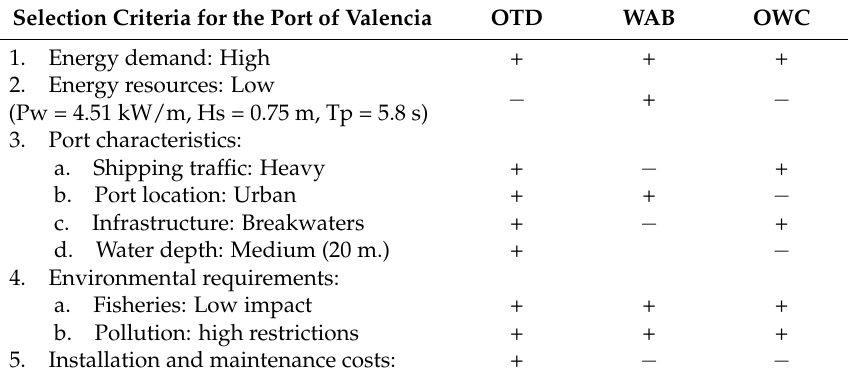
Table 9. WEC selection criteria for the Port of